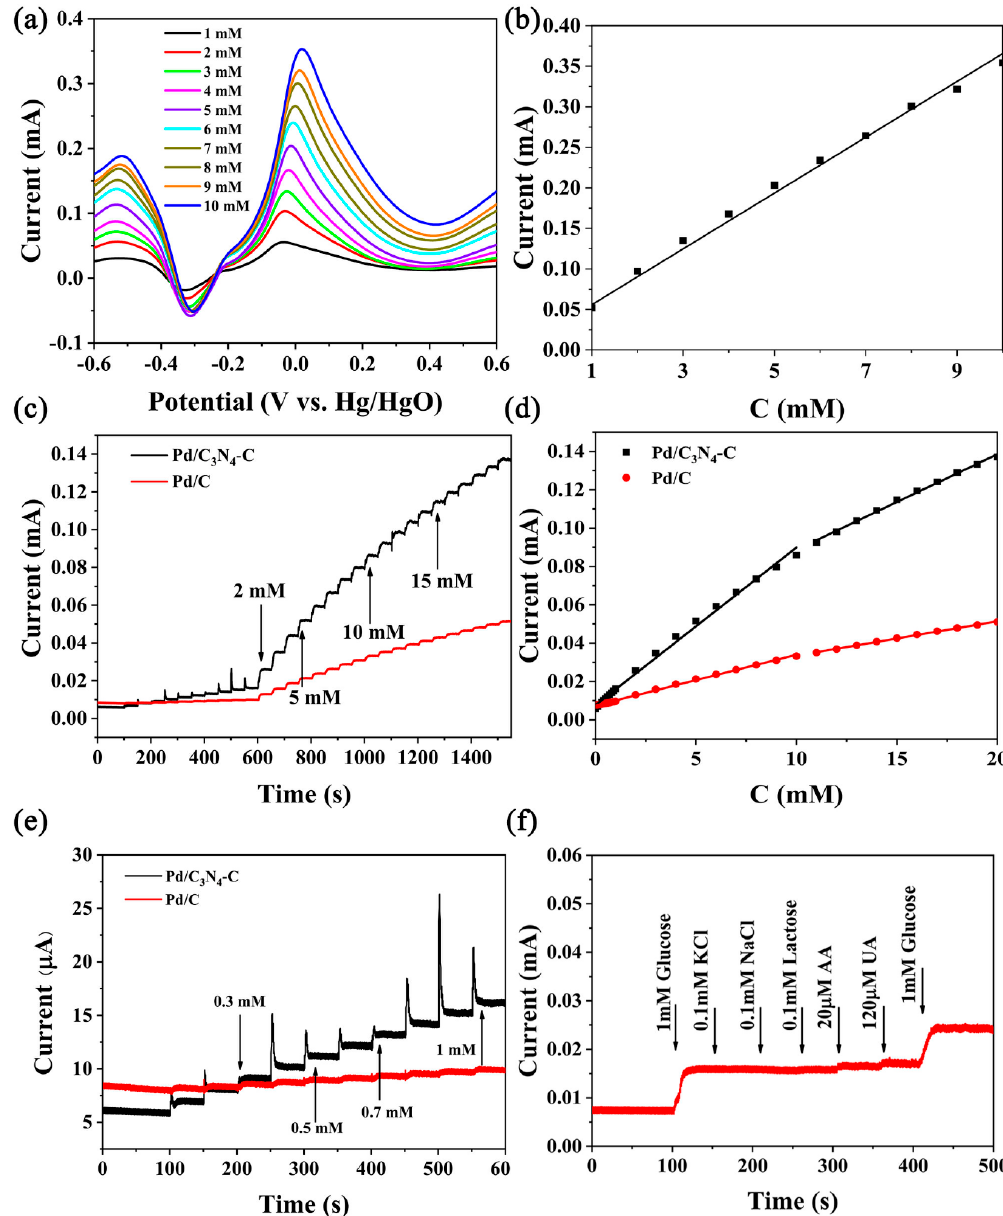
Figure 6. ( a ) The linear scanning voltammetry (LSV) curves of Pd/C 3 N 4 -C in the presence of glucose in 0.1 M NaOH. The scan rate of 50 mV s − 1 . ( b ) The calibration curve of glucose sensing at Pd/C 3 N 4 -C corresponding to the LSV curves. ( c ) The amperometric responses of Pd/C 3 N 4 -C and Pd/C to glucose. 0.5 V vs. Hg/HgO. ( d ) The calibration curves obtained from the amperometric curves. ( e ) The amperometric response of 0.1–1 mM glucose at Pd/C 3 N 4 -C and Pd/C. ( f ) The current response of Pd/C 3 N 4 -C to interfering substances compared with glucose.